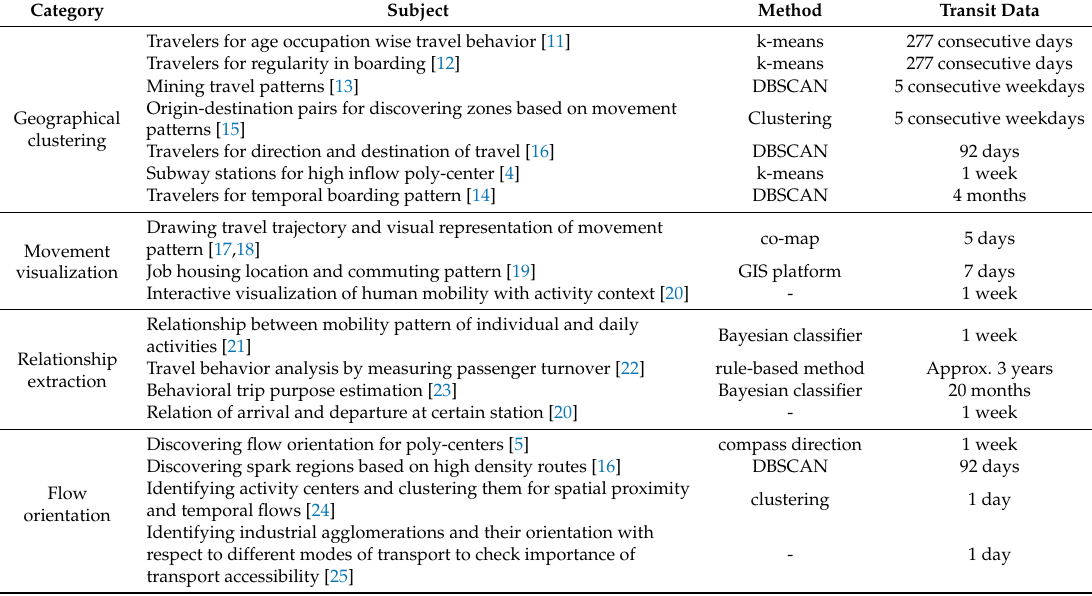
Table 1. Related studies on human mobility using smart card transit